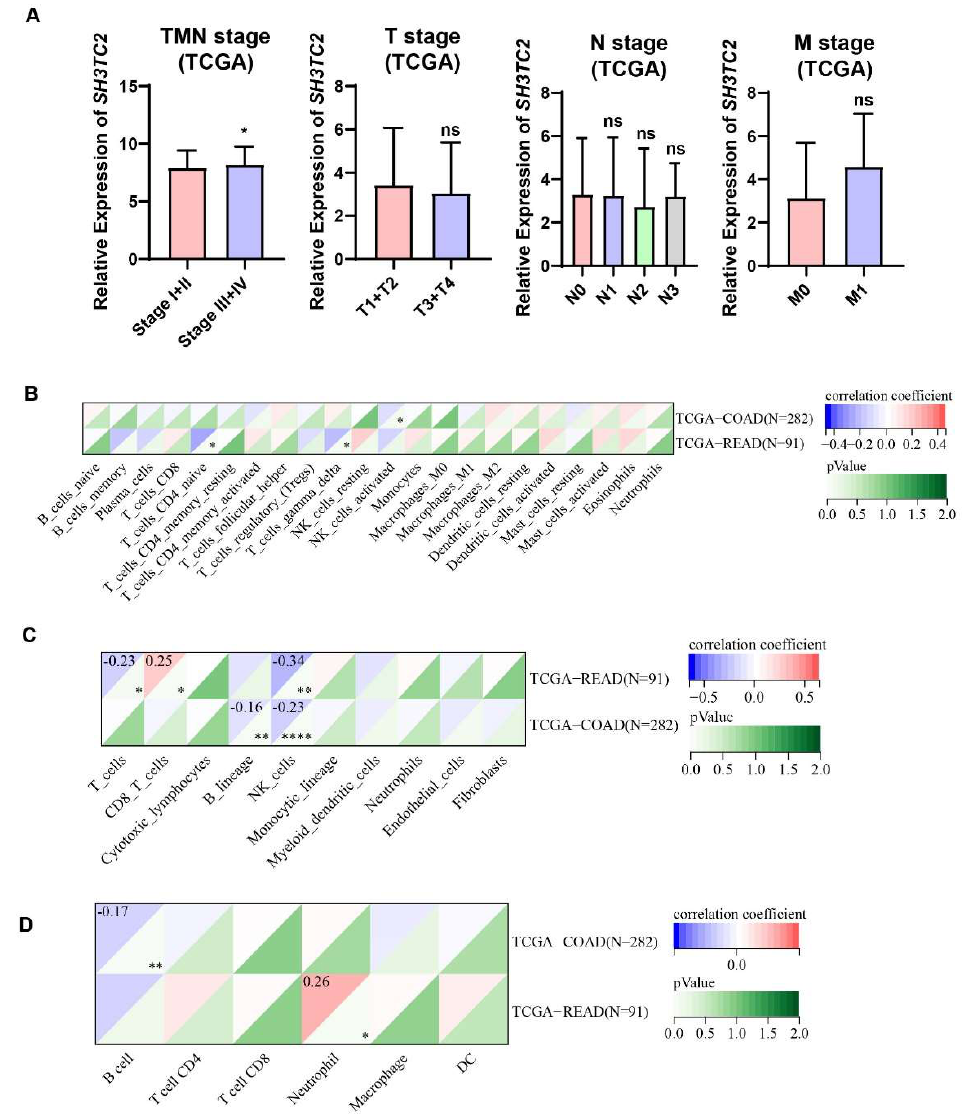
Figure 2. Analysis of TCGA database revealed the expression of SH3TC2 and clinical characteristics in CRC. ( A ) Advanced CRC patients had higher expression of SH3TC2. However, expression of SH3TC2 did not correlate with the T, N, or M stages. Cibersoft ( B ), MCPCounter ( C ), and TIMER ( D ) analyses revealed that the expression of SH3TC2 may correlate with T−cell infiltration. Statistical analysis was compared to the control or normal groups: ns, not significant; * p < 0.05; ** p < 0.01; **** p < 0.001.